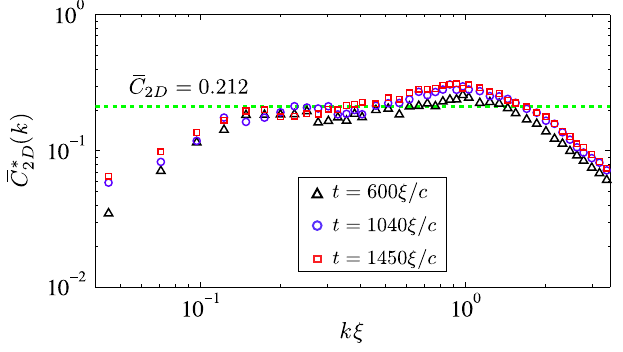
ð k Þ [see Eq. (96)] computed from the grid FIG. 8. Plot of (cid:5) C (cid:13) 2D turbulence kinetic-energy spectra of Fig. 7. The horizontal from Eq. dashed line gives (cid:5) C 2D